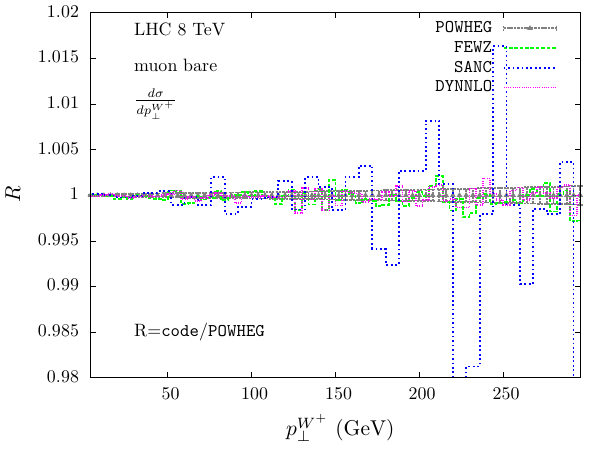
Fig. 7 Tuned comparison of the lepton-pair transverse momentum distribution in pp → W + → μ + ν μ + X at the 8 TeV LHC with ATLAS/CMS cuts in the bare setup at high p W ⊥ , including NLO QCD corrections